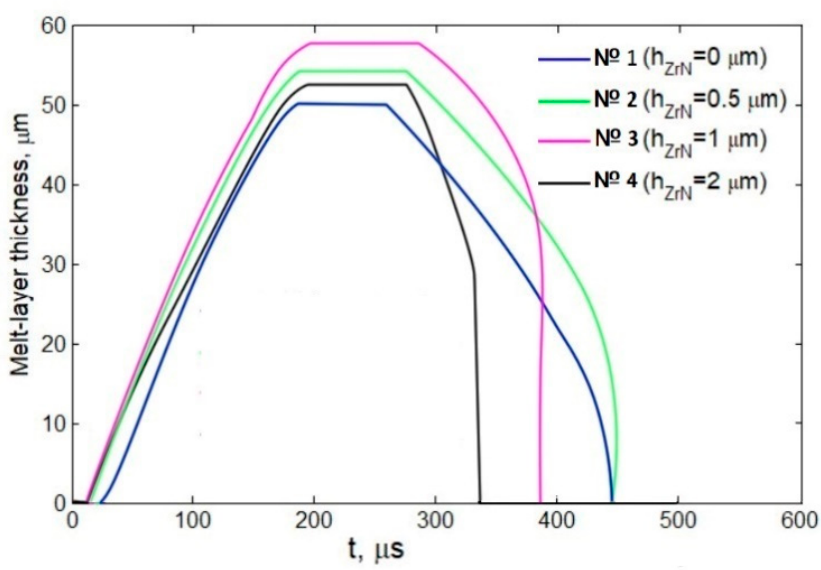
Figure 9. Time variations of the melt depth for the bare silumin sample and for the silumin samples with a coating of thickness 0.5, 1, and 2 µ m.